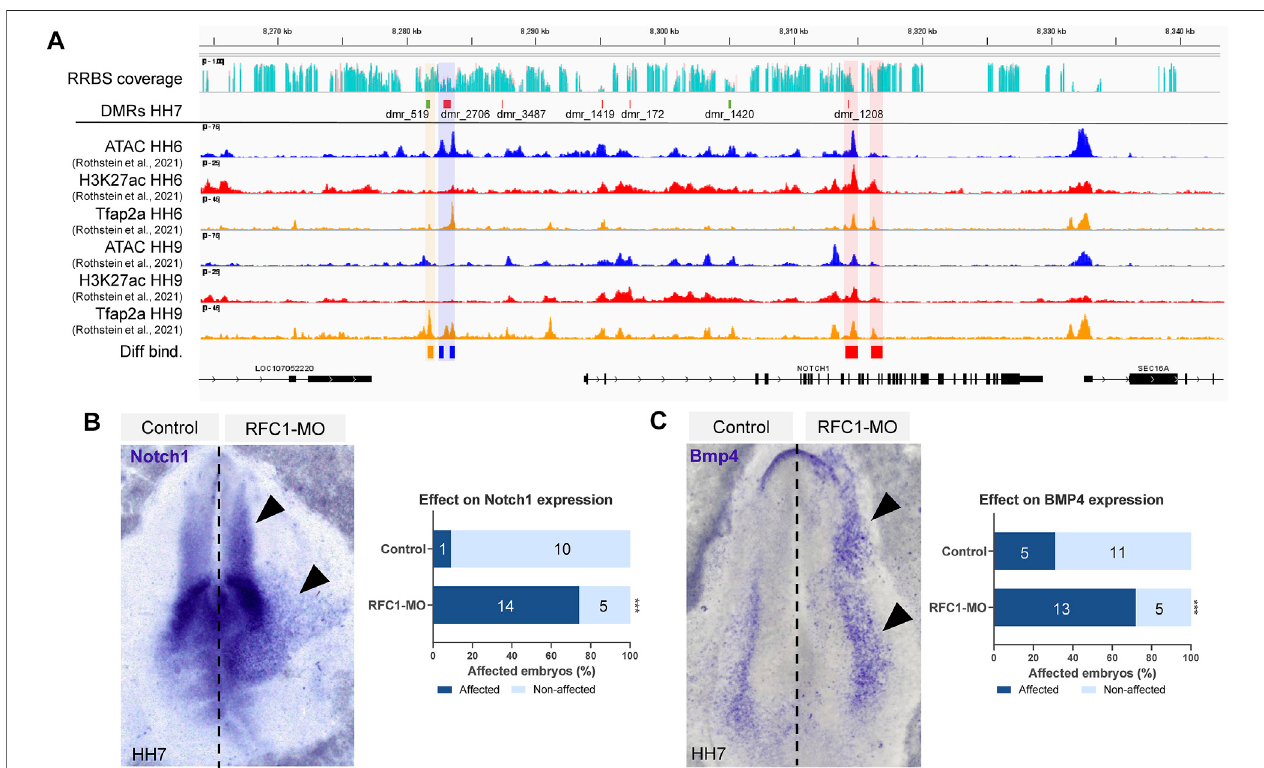
FIGURE 5| Folate carrier de fi ciency generated DMRs at the Notch1locusand affect its expression. (A) IGVvisualization ofthe Notch1 locus and its vicinity, RRBS read coverage (Control in turquoise and RFC1-MO in orange), hyper (green) and hypo (red) methylated DMRs at HH7 embryos. ATAC-seq, H3K27ac, and TFAP2A CUT&RUN pro fi les at HH6 and HH9 (data obtained from Rothstein et al. (2020)). Three DMRs are found upstream of the Notch1 gene, whereas four are located in the gene body. Differentially accessible elements (shaded in blue), H3K27ac abundance (shaded in red), or Tfap2A binding (shaded in orange) comparing HH6 and HH9weredeterminedbyDiffBindusinganegativebinomialdistributionmodel(FDR < 0.1).Whole-mount insitu hybridizationof Notch1 (B) and Bmp4 (C) inthebilaterally electroporated embryos injected with control or RFC1 morpholinos. Black arrowhead pointed out increased and ectopic expression in the treated side. Bar graphs represent the quantitation of embryos following RFC1-MO presenting increased and ectopic expression for Notch1 or Bmp4 (affected) and comparing with the control- MOtreatedembryos.Numbersinthegraphrepresentthenumberofanalyzedembryos.StatisticalanalysiswereperformedbythecontingencytablefollowedbyFisher ’ s exact test (***: p =